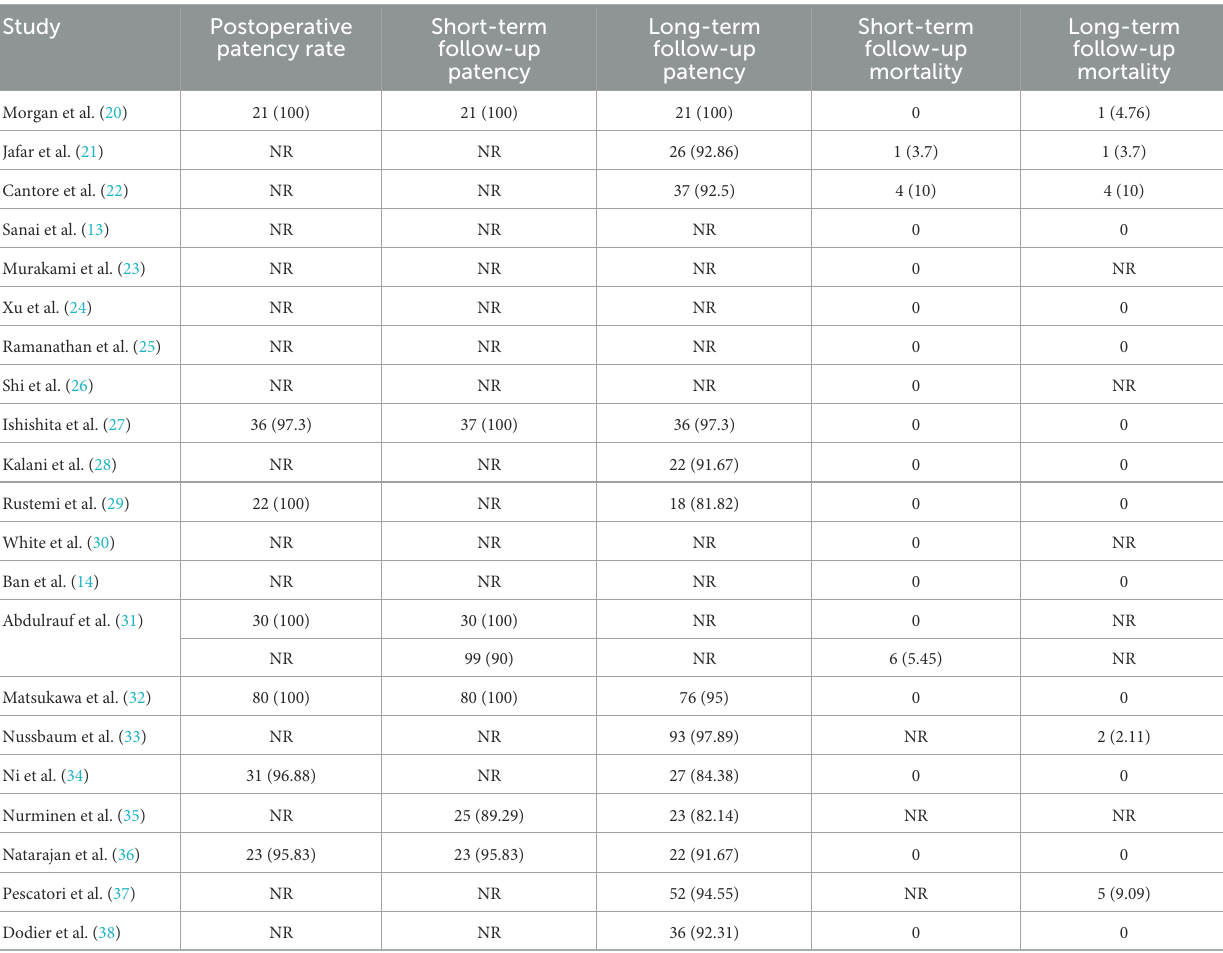
TABLE 3 Primary outcomes of included studies.